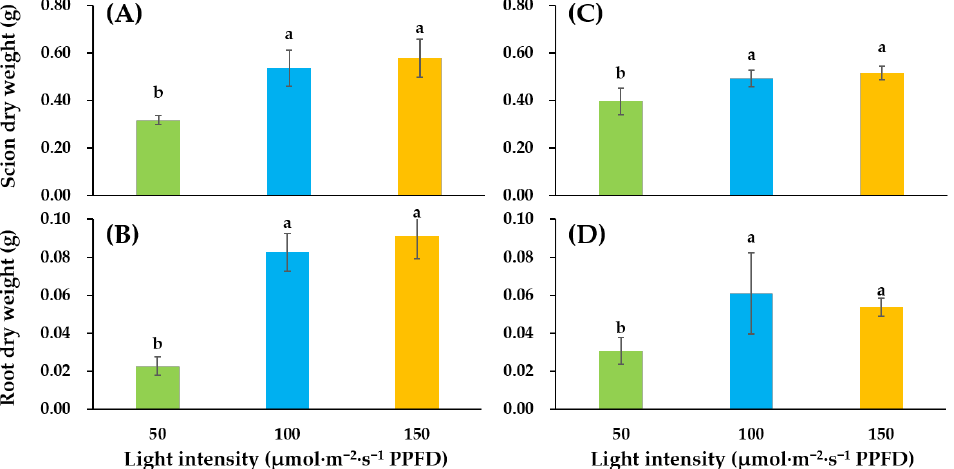
Figure 1. Influence of supplementary lighting intensity on dry weight of shoots and dry weight of roots of two cultivars of tomato ‘Super Sunload’ (‘SS’) ( A , B ) and ‘Super Dotaerang’ (‘SD’) ( C , D ) grafted onto the ‘B-Blocking’ rootstock. Error bars represent SEs of nine biological replicates ( n = 9). According to the Duncan test, lowercase letters at p ≤ 0.05 indicate significant differences between different treatments.